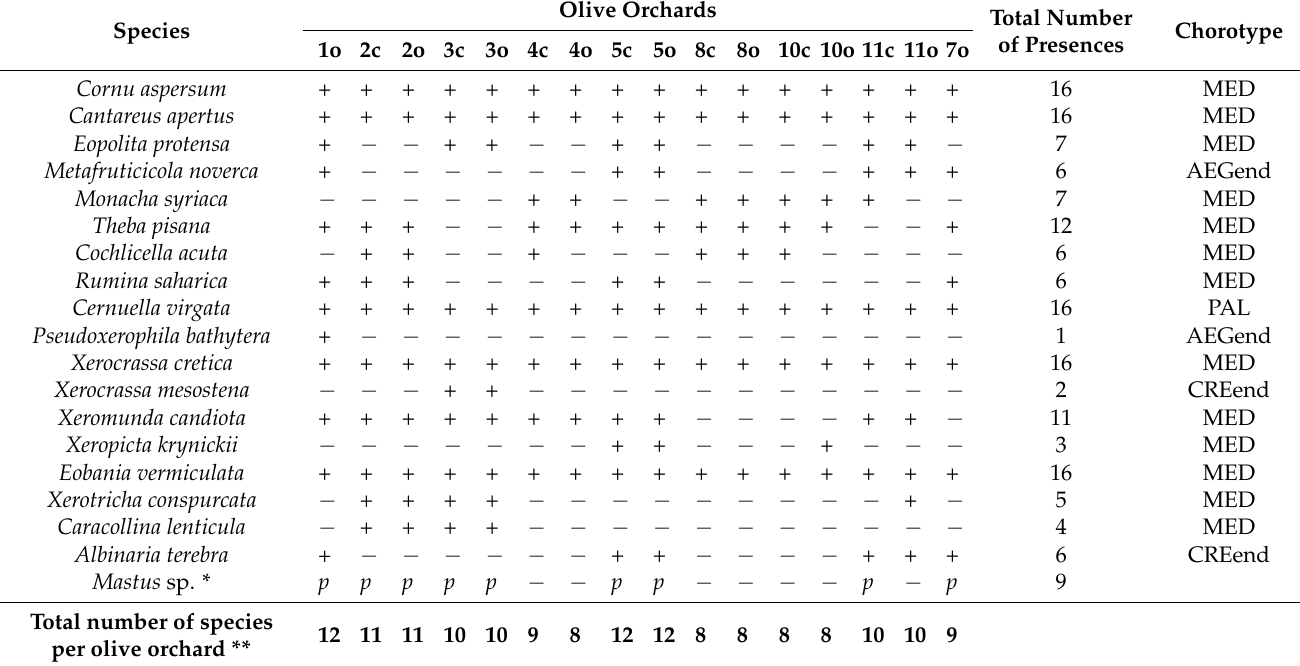
Table 1. List of species found in the 16 olive orchards under investigation and their chorotype (MED-Mediterranean, AEGend-Aegean endemic, PAL-Palearctic, CREend-Cretan